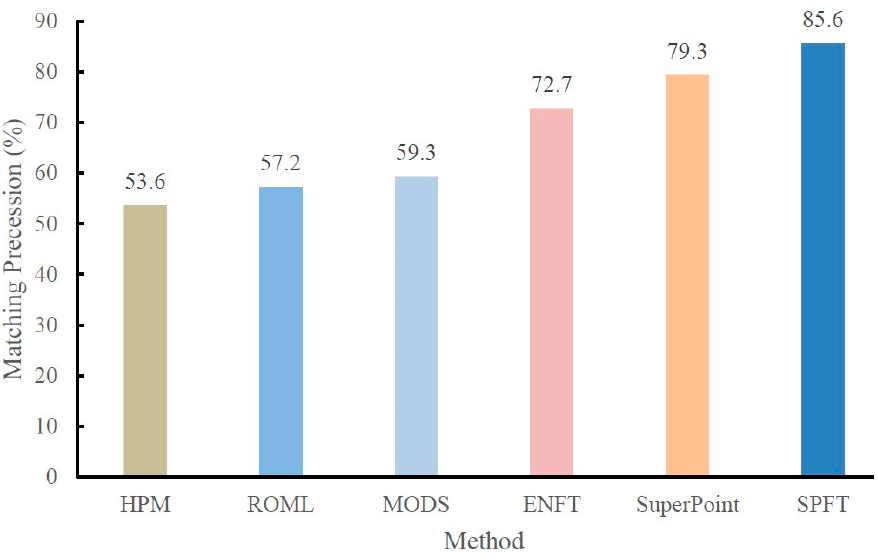
Figure 8. Averaging matching precessions for the evaluated methods, where the SPFT has the best performance, the SuperPoint is in the second place. performance, the SuperPoint is in the second